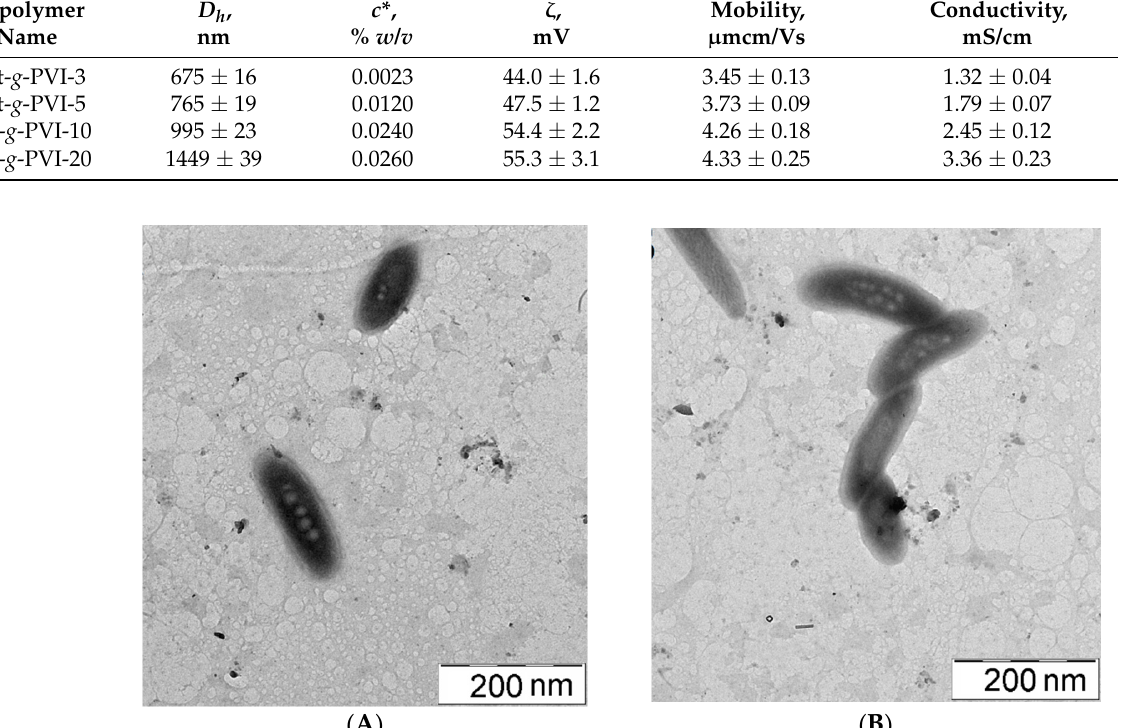
Figure 2 . The TEM images of the Cht- g -PVI-3 graft copolymer particles at c < c* ( A ) and c > c* ( B ) . Table 3. The characterization of the 0.1% w/v Cht- g -PVI copolymer aqueous solutions (pH = 6.5 ± 0.02).